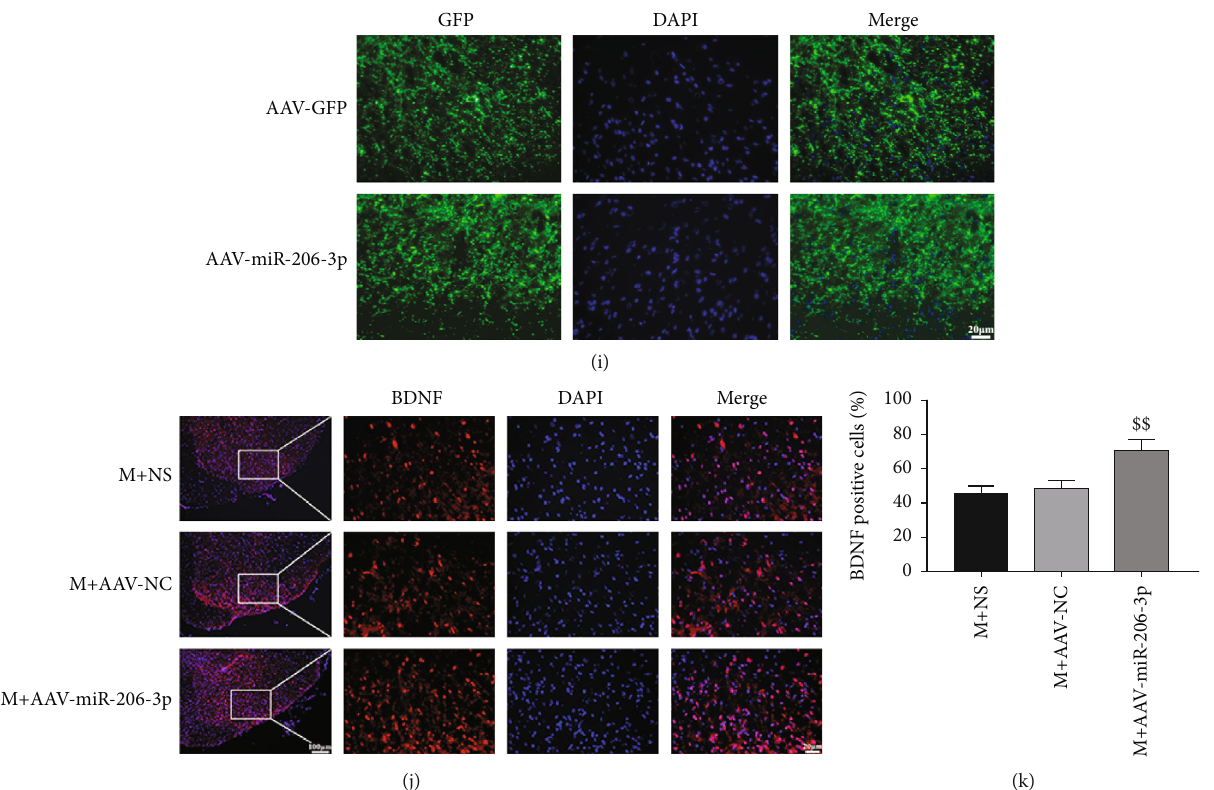
Figure 4: A miR-206-3p inhibitor increased the expression of BDNF, BAX/Bcl-2, IL-6, and TNF- α after CCI. (i) Staining for green fl uorescent protein- (GFP-) positive cells (scale bars: 20 μ m, 400x). (a – c) The mRNA and protein expression of BDNF/GAPDH ( n = 5 ). (j, k) Staining for BDNF-positive (red) cells (scale bars: 100 μ m, 100x; 20 μ m, 400x) ( n = 5 ). (d – g) Representative western blots and quanti fi cation data of BAX/Bcl-2, IL-6/GAPDH, and TNF- α /GAPDH ( n = 5 ). Bars indicate the mean ± SD . $ p < 0 : 05 and $$ p < 0 : 01 versus M+NS